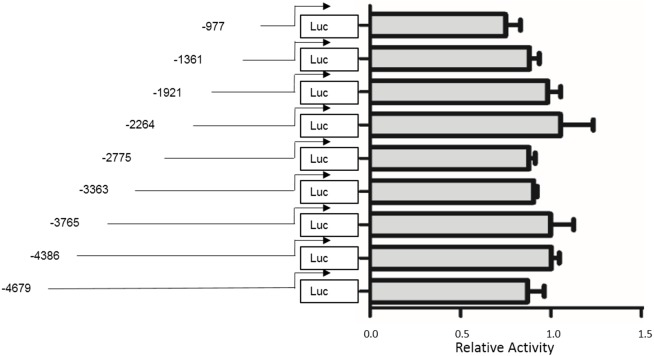
Functional analysis of different lengths of putative promoter sequences of H19 in MAC-T cells.The different 5′ truncated fragments upstream of H19 gene sequences were generated and inserted into the Luc-vector. Fragment lengths are indicated relative to the transcription start site, and the activity of the fragments constructs relative to a promoter-less construct is shown. P > 0.05 among all groups.